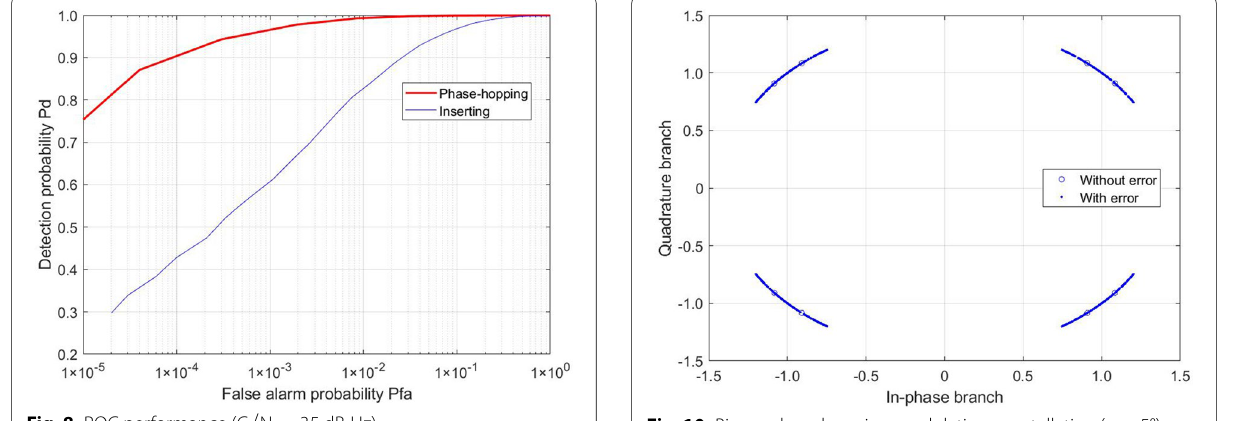
Fig. 10 Binary phase hopping modulation constellation ( σ i